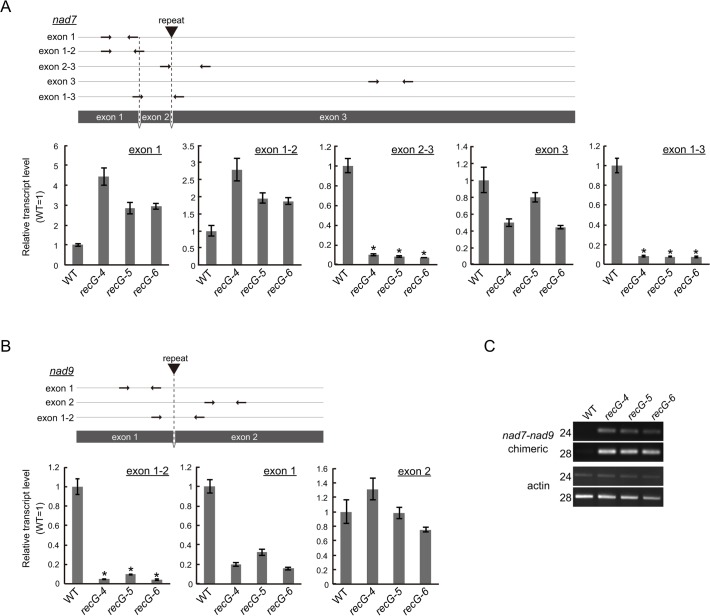
Mitochondrial transcripts in RECG KO plants.
A and B. Detailed qRT-PCR analysis of nad7 (A) and nad9 (B) transcripts. Positions of the primers used in the qPCR are schematically represented in the upper parts of the panels. Coding regions are represented by grey boxes. Positions and directions of the primers are shown by arrows. Positions of the repeats involved in the rearrangements between nad7 and nad9 are indicated by triangles. Relative levels of segments of mitochondrial transcripts from nad7 and nad9 were normalized to reference of nuclear gene ST-P 2a transcript. WT was given a value of 1. Slight or no amplification was observed in no reverse-transcription controls (S5G Fig.). The data represent mean of three replicates ± SD. *p<0.01 (versus WT). C. RT-PCR analysis of nad7-nad9 chimeric transcripts. nad7-nad9 chimeric transcripts were amplified using cDNA from WT and RECG KO lines at cycles indicated on the left of the picture. Actin was amplified as an internal control.